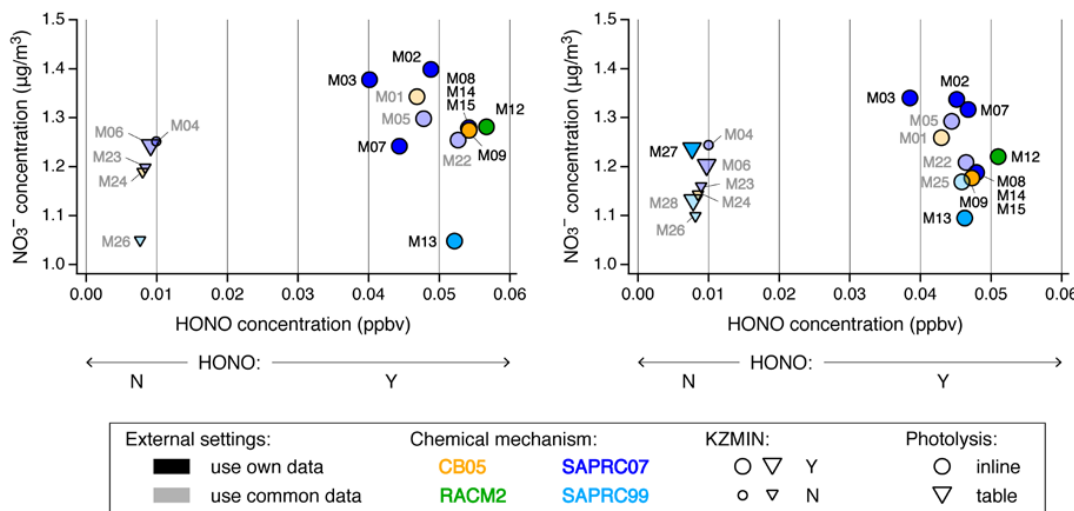
Figure 15. Summary of the e ff ects of the model external and internal setting on NO 3 − concentration averaged over (left) domain 3 and (right) domain 4. For the external settings, models that used their own data are shown by opaque shading, and models that used the common data are shown by transparent shading with gray texts. The chemical mechanisms are indicated by color: CB05 is orange, RACM2 is green, SAPRC07 is blue, and SAPRC99 is sky blue. Large symbols indicate that KZMIN was used, and small symbols indicate KZMIN was not used. Inline and table photolysis calculations are indicated by circles and triangles, respectively. The internal settings for HONO are shown by the HONO concentration on the x -axis.